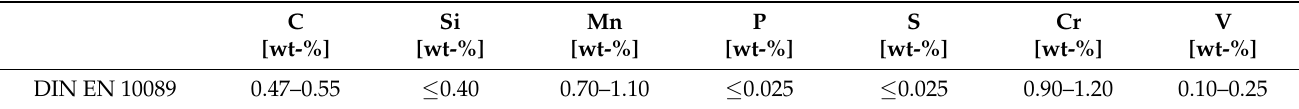
Table 1. Chemical composition of the 51CrV4 steel grade according to DIN EN